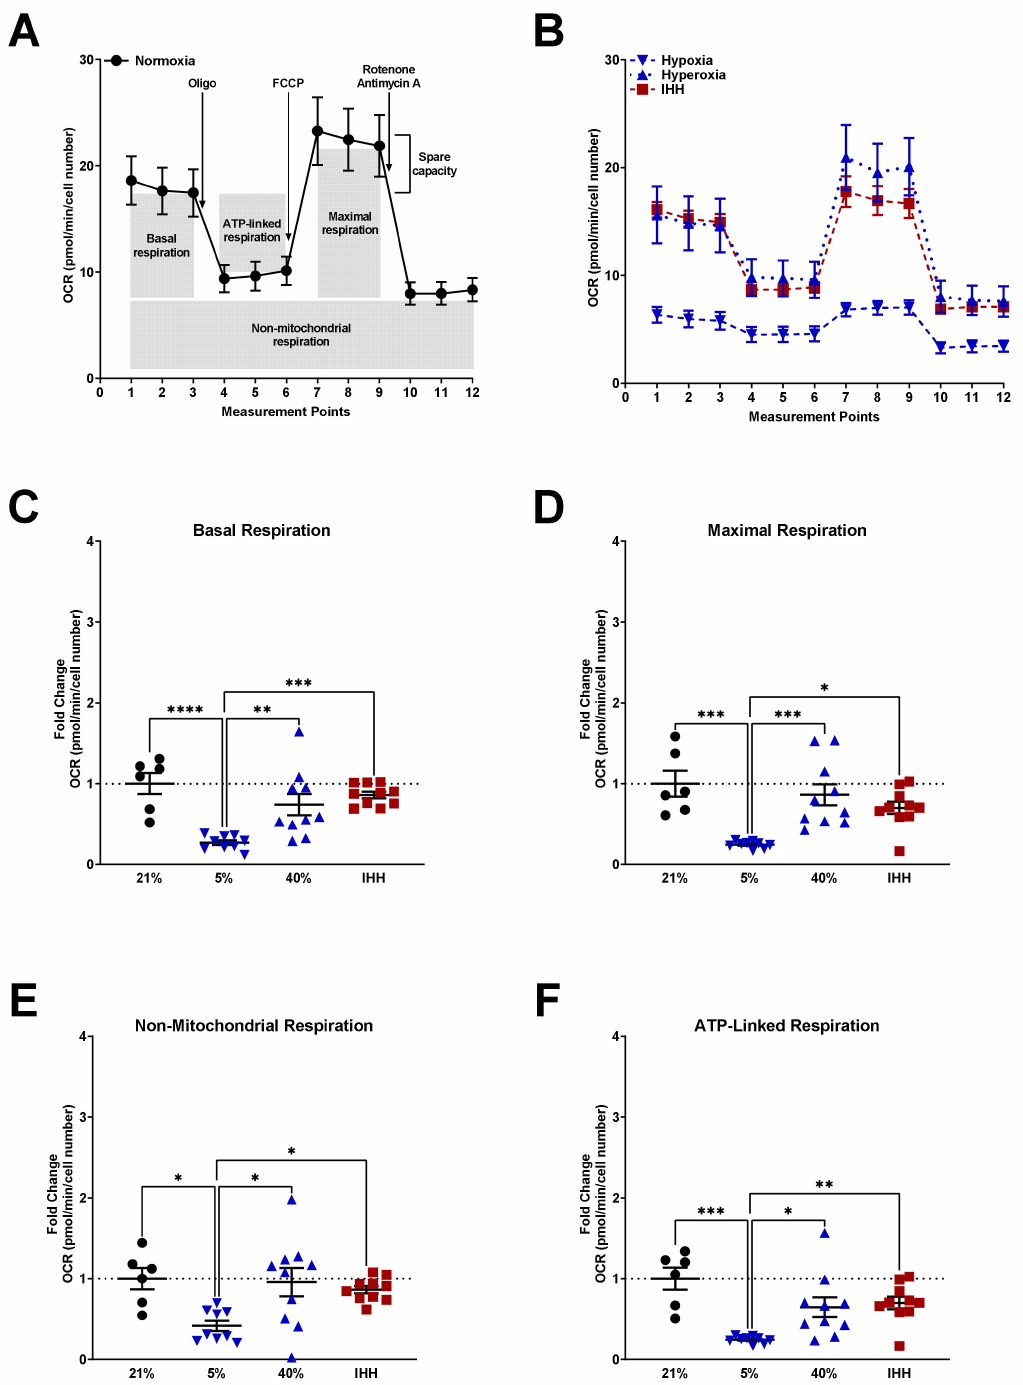
Figure 3. Mitochondrial respiration in fASM exposed to normoxia, hypoxia, hyperoxia, or IHH. Human fASM were exposed to either 5% O2, 21% O2, 40% O2, or IHH for 24 hours prior to mitochondrial stress test using a Seahorse Bioanalyzer. Mitochondrial stress test entails consecutive addition of oligomycin (inhibits ATP synthase), FCCP (uncouples ATP